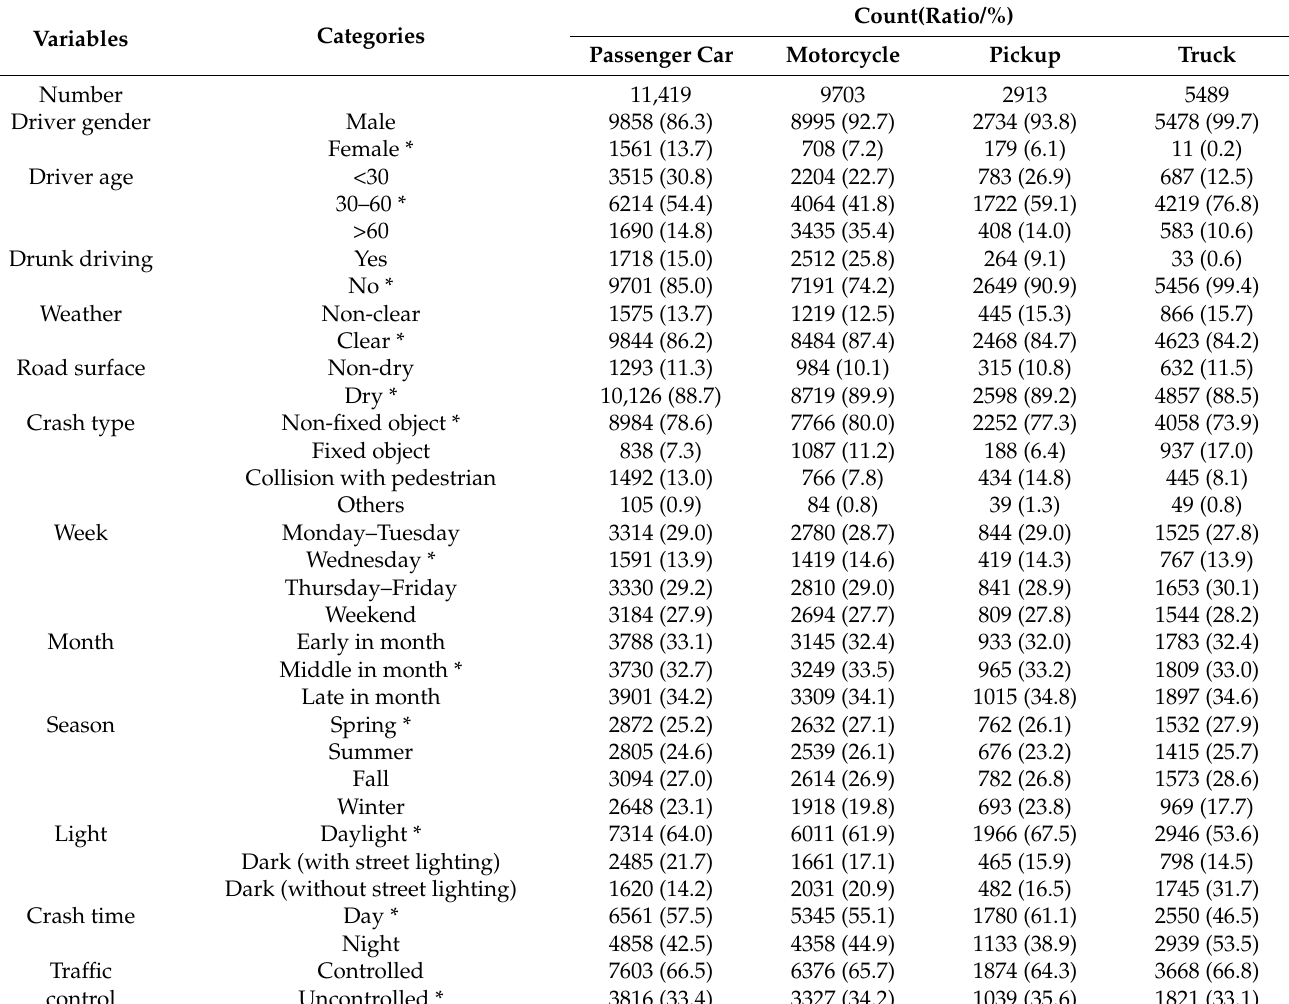
Table 1. Descriptive statistics of model variables across vehicle